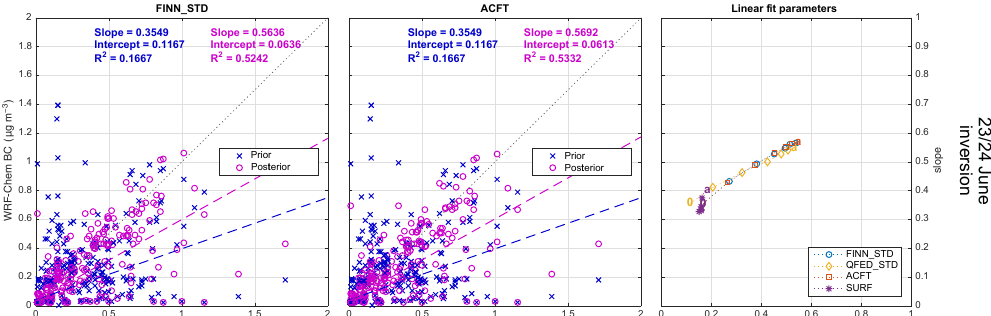
Figure 6. Prior and posterior model versus 24 June ARCTAS-CARB observations for the 23/24 June FINN_STD inversion. The left plot uses both IMPROVE (23 June) and ARCTAS-CARB observations in the inversion. The middle plot uses only ARCTAS-CARB. The plot on the right shows the progression of the slope and R 2 from the prior, “0”, to the posterior, “a”, for similar linear regressions.